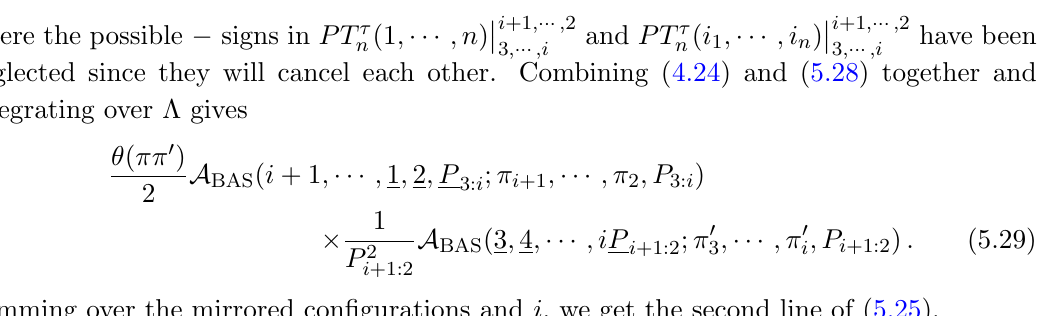
( i 1 ; (cid:1) (cid:1) (cid:1) ; i n ) n